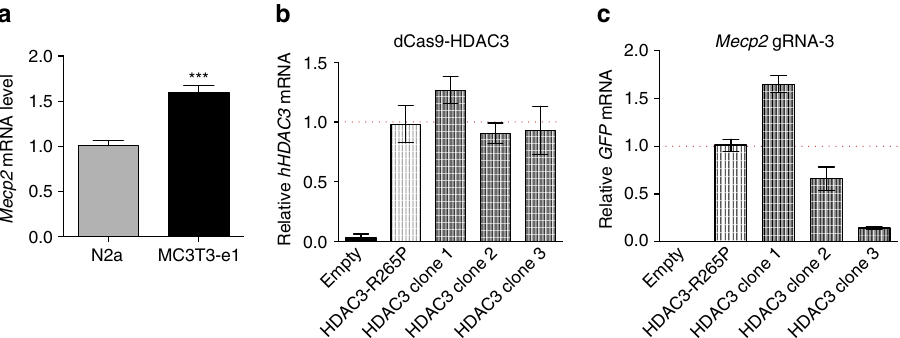
Figure 3 | Generation of dCas9-HDAC3 and dCas9-HDAC3 R265P MC3T3-e1 clonal cell lines targeting the Mecp2 promoter. ( a ) RT–PCR analysis of Mecp2 expression in MC3T3-e1 cells relative to that of N2a cells. *** P o 0.001; n ¼ 5 biological replicates; error bars, s.e.m. ( b ) Relative mRNA levels of human HDAC3 and ( c ) GFP in non-infected ‘empty’ murine MC3T3-e1 cells and MC3T3-e1-derived clonal cell lines stably expressing dCas9 fusion proteins and